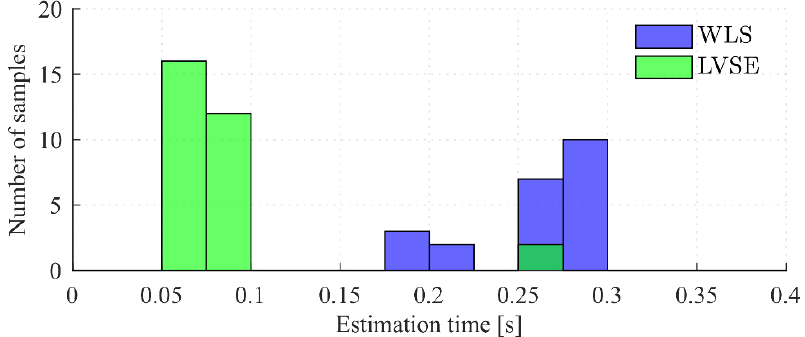
Figure 10. Estimation duration distributions — case 3.